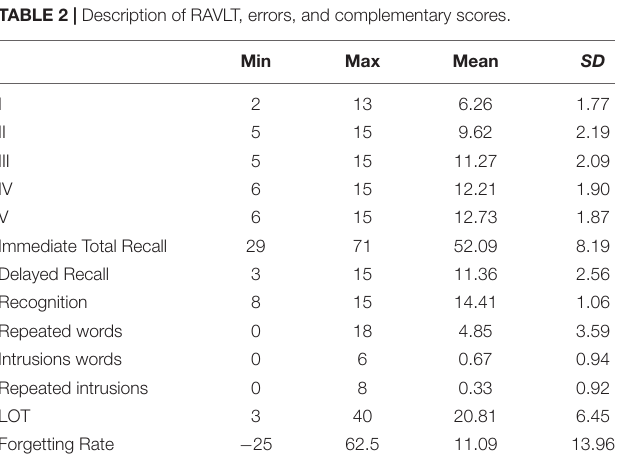
TABLE 2 | Description of RAVLT, errors, and complementary